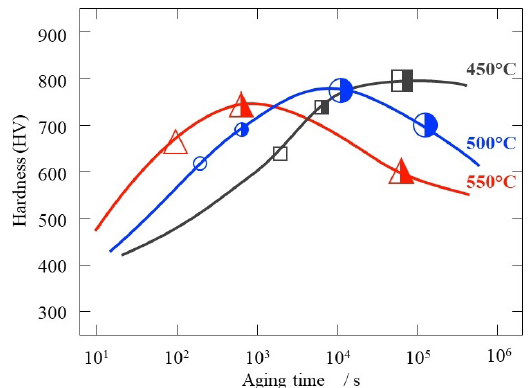
Figure 8. Vickers hardness as a function of aging time (in seconds) for the Fe-13.01Ni-15.30Co-9.83Mo-0.24Ti steel for three temperatures:450 °C (squares); 500 °C (circles) and 550 °C (triangles). Open symbols indicate the presence of Ni indicate the simultaneous presence of Ni of the symbols indicates the size of the precipitates: small and large mean smaller and larger than 4 nm, respectively 41